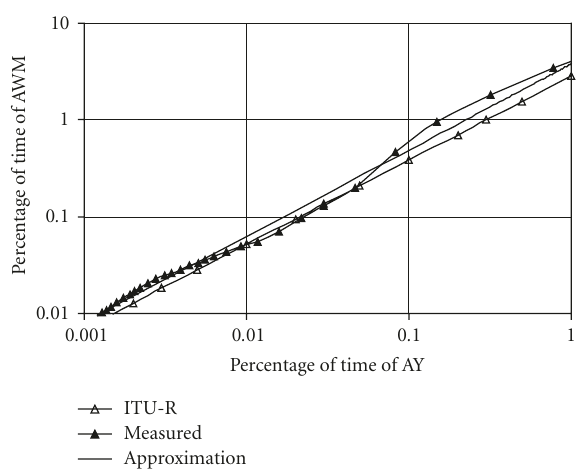
Figure 13: Dependence of percentages of time of AWM on percent- ages of time of